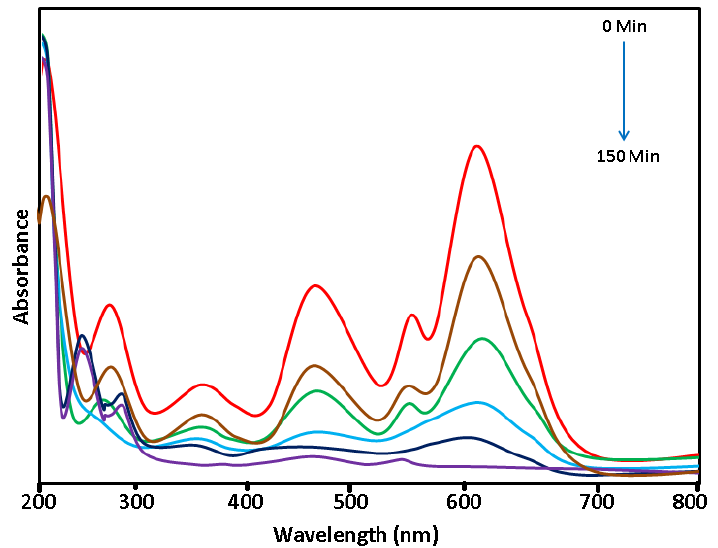
Fig. 11. UV-Visible spectra of Industrial wastewater